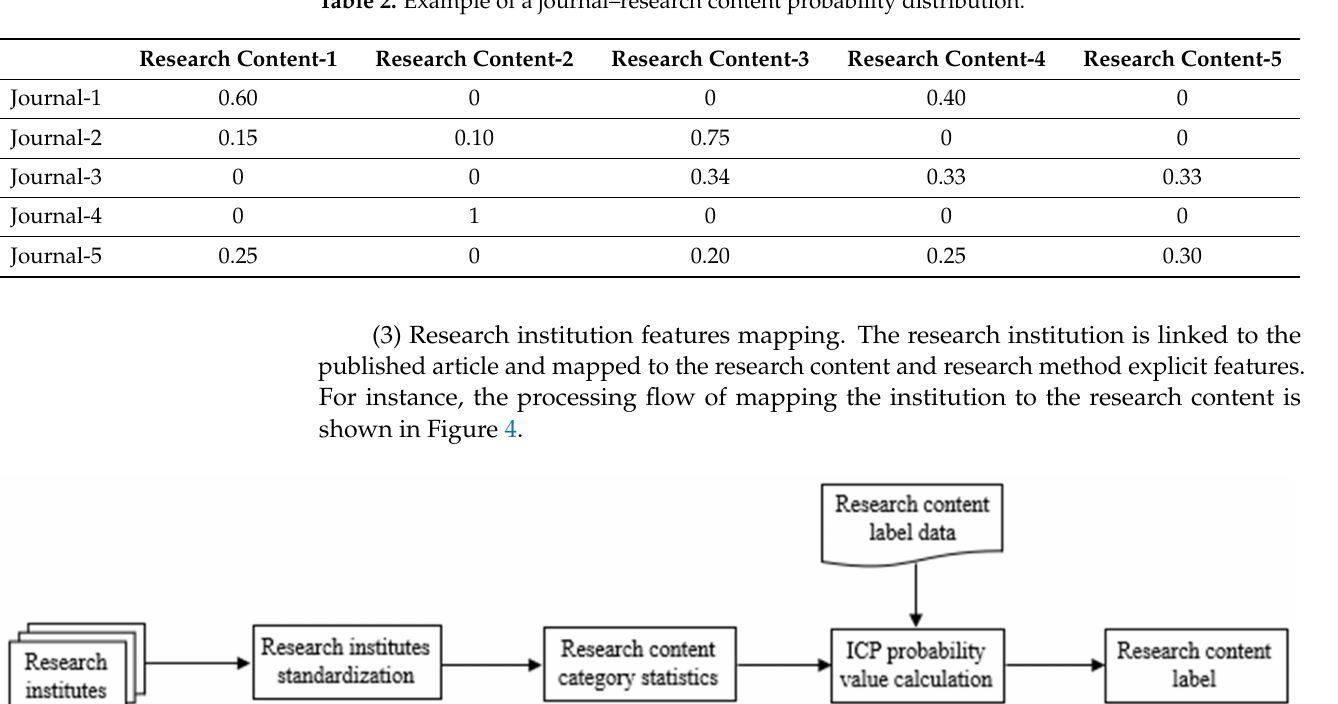
Table 2. Example of a journal–research content probability distribution.